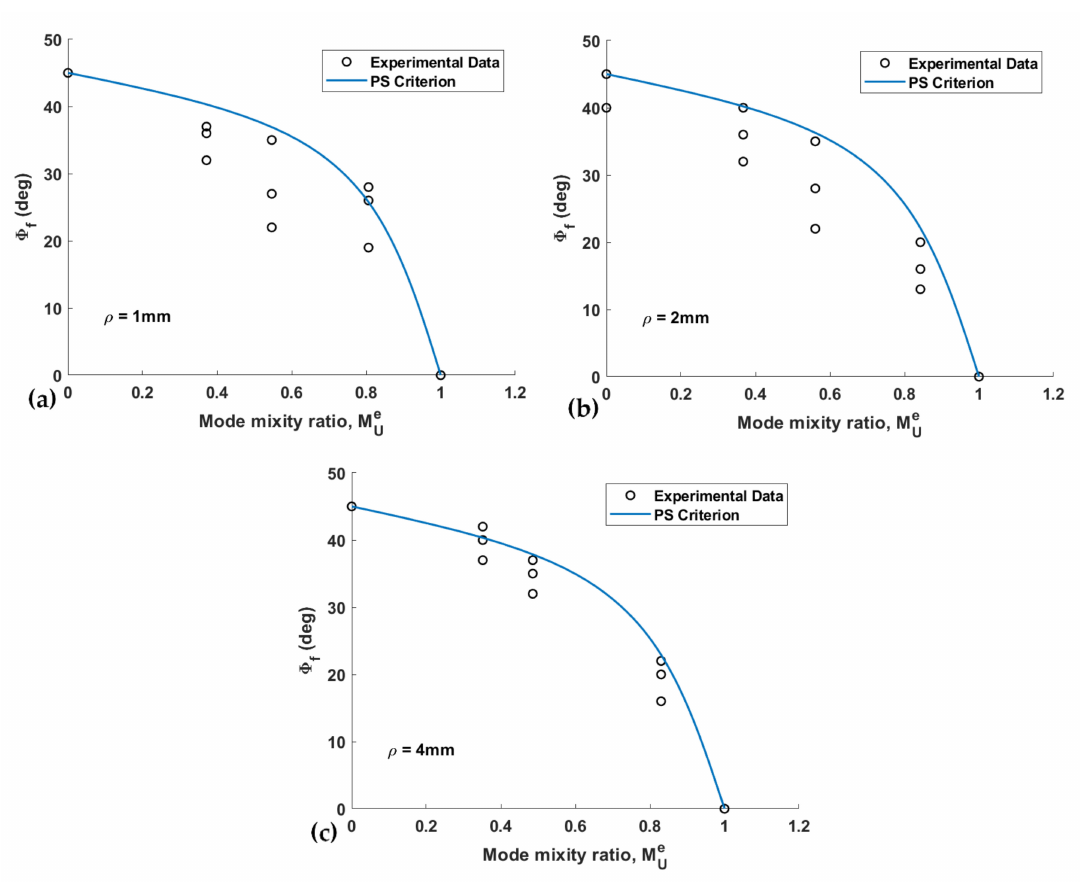
Figure 13. Out-of-plane fracture angle predicted by the PS criterion and corresponding experimental data. ( a ) ρ = 1 mm; ( b ) ρ = 2 mm; ( c ) ρ = 4